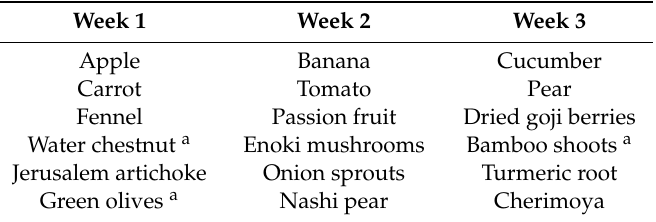
Table 1. Overview of the taste samples used for the home